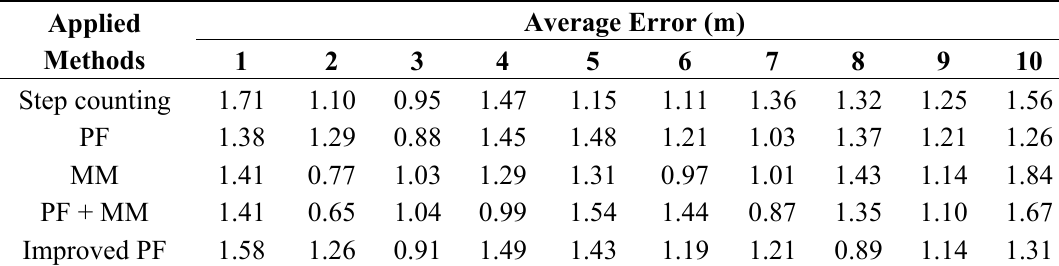
Table 6. Average error for each trial (map 2, route 2).